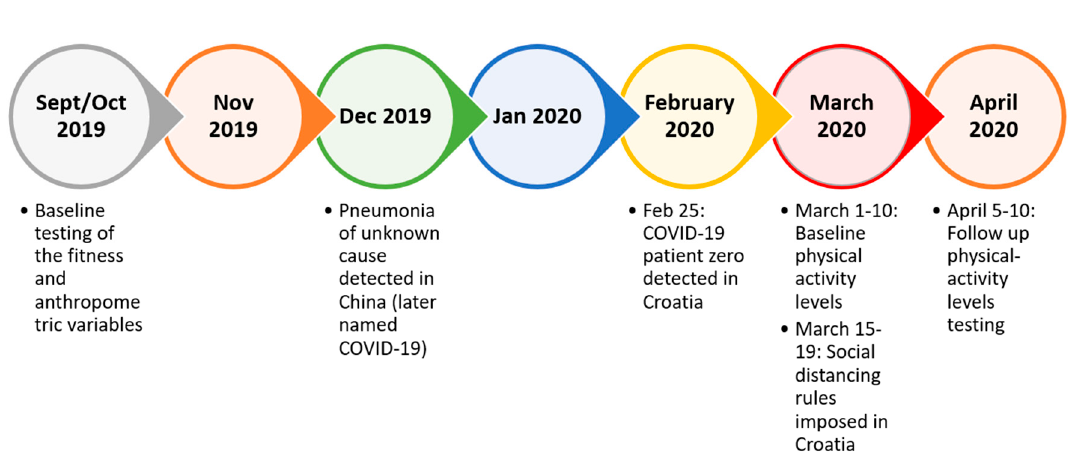
Figure 1. Study design and most important time frames .